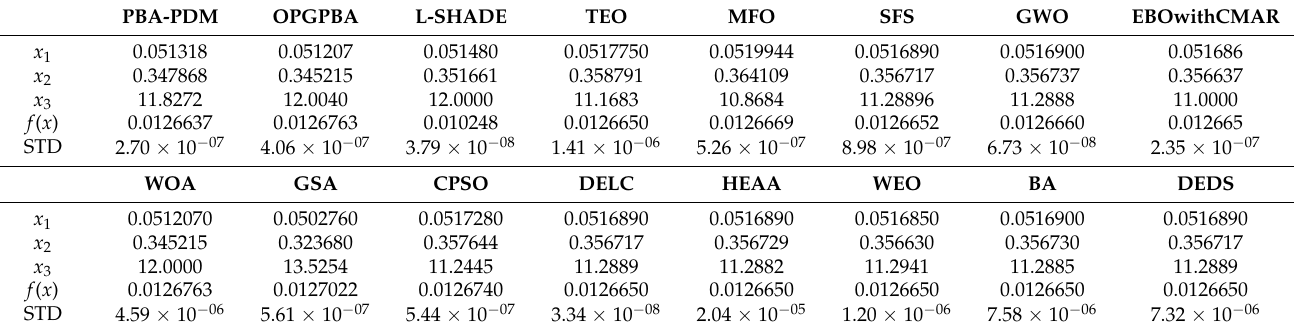
Table 18. The comparison of PBA-PDM with other optimizers in Tension/Compression Spring Design.